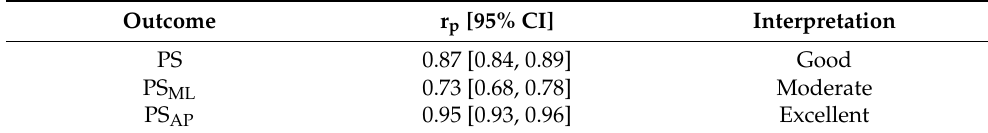
Table 3. Validity of postural stability outcomes obtained from the Gait&Balance (G&B) application compared to the 3D motion capture (MoCap) system.